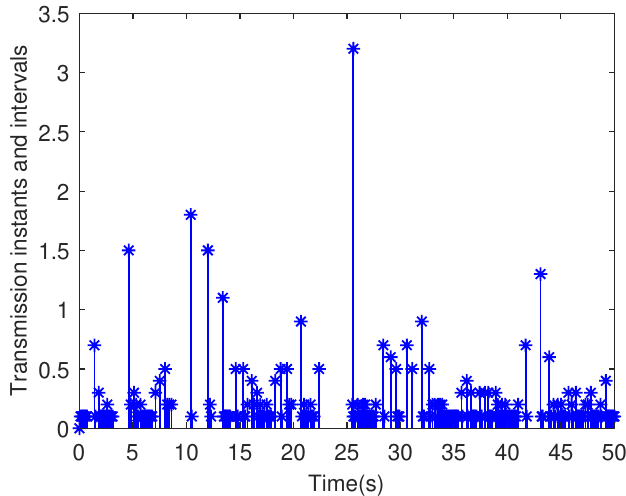
Figure 2. Transmission instants and intervals.